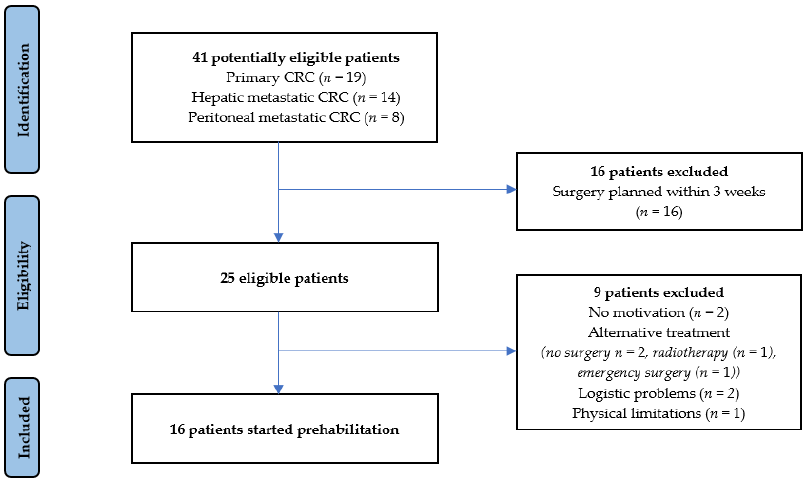
Figure 1. Flow chart for inclusion and exclusion.